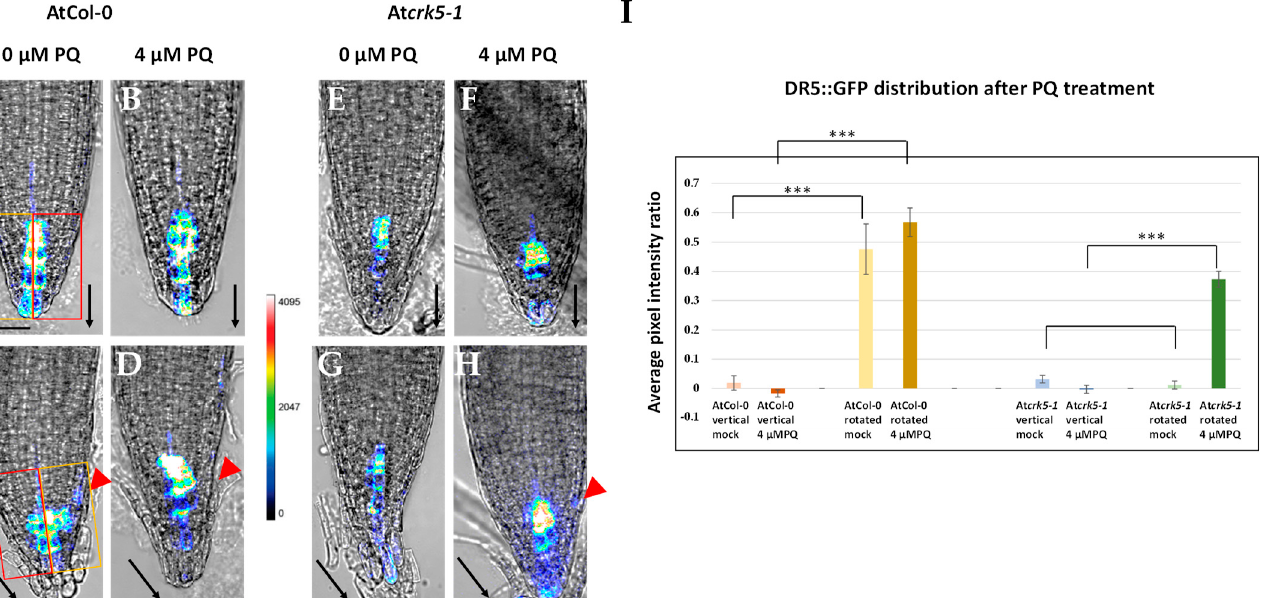
Figure 4. Fluorescence intensity heat maps of DR5::GFP signals in root tips. Activity of the auxin-induced DR5::GFP reporter in the 6-day-old wild type (AtCol-0; A – D ) and mutant (At crk5-1 ; E – H ) roots during vertical growth ( A , B , E , F ) or after gravistimulation (-135° rotation for 4–5 h; C , D , G , H ) in the absence ( C , G ) and presence ( D , H ) of 4 µM PQ. ( I ) Quantification of the DR5::GFP fluorescence intensity ratio by investigating the average pixel intensities of the GFP signals measured in equally-sized areas at both sides of the root by ImageJ/Fiji. At least 5–10 images from the wild type and the mutant categories were analysed in each version from three independent experiments. Values near zero represent a symmetrical DR5::GFP signal position, while values higher than 0 mean an asymmetrical DR5::GFP signal position. Asterisks indicate significant difference between the corresponding mock control and the treatment (two-way ANOVA, means comparison was carried out by Bonferroni; *** p < 0.001). The fluorescence intensity was translated into a colour code (scale is in the middle). Black arrows show the direction of the gravity vector. Red arrowheads indicate the lateral redistribution of the signal towards the gravity vector. Rectangles on ( A , C ) images represent the equally sized areas. Scale bar: 50 µm. The original DR5::GFP fluorescence images (without heatmap) are shown as Supplemental Figure S1.